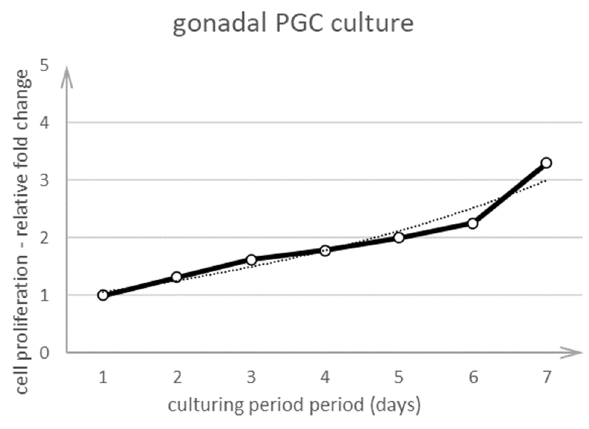
Figure 5. Proliferation curve of gPGCs cultivated on a chicken embryo feeder layer at pH 8.0. The live gPGCs cells were counted directly in the culture by using the darkfield illumination method.